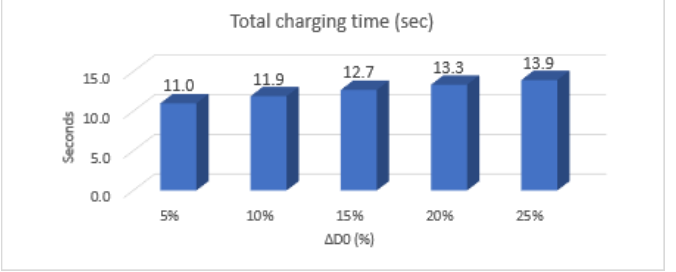
Figure 28. SC circuit charging duration diagrams in case of six-phase converter at different ∆ D 0 .